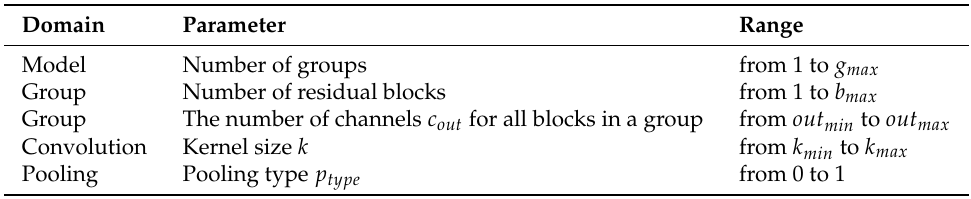
Table 1. The optimized network parameters and their corresponding search ranges. The settings of the search ranges used in our experiments are provided in Section 4.